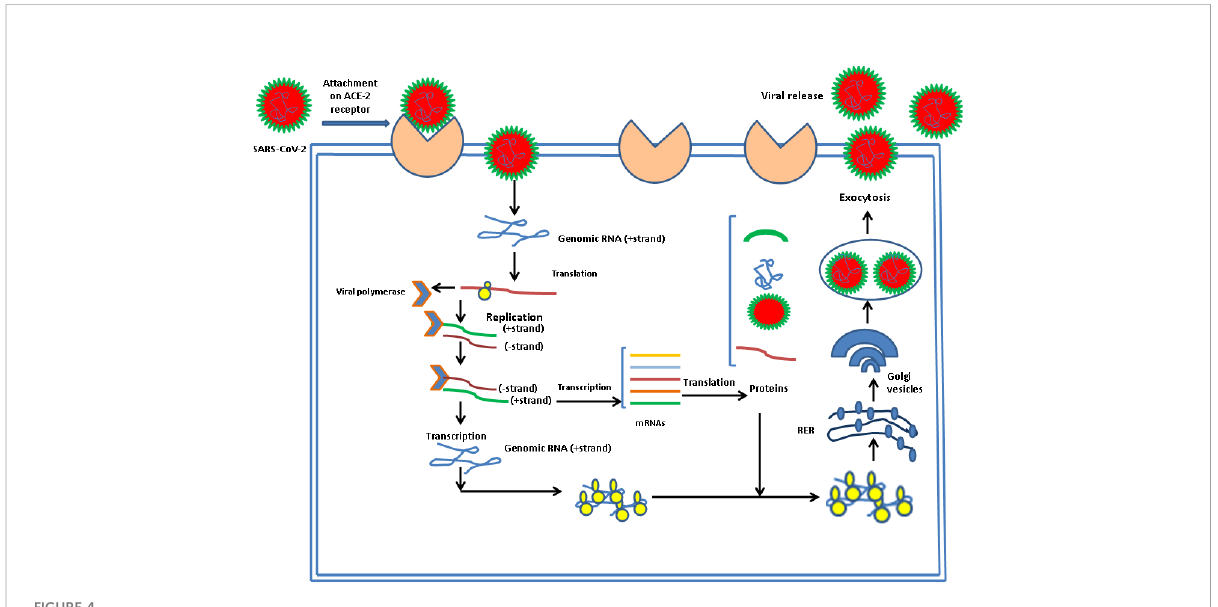
FIGURE 4 Entry, uncoating, and replication of SARS-CoV-2 in